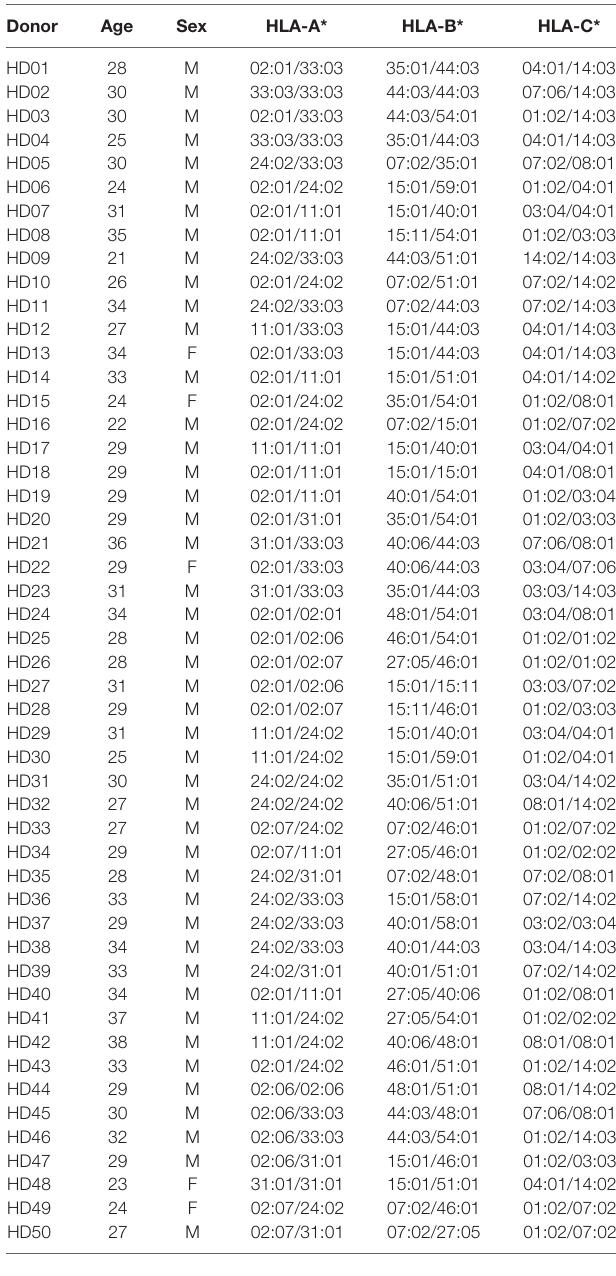
TaBle 1 | Genotypes of HLA class I alleles in 50 healthy Korean